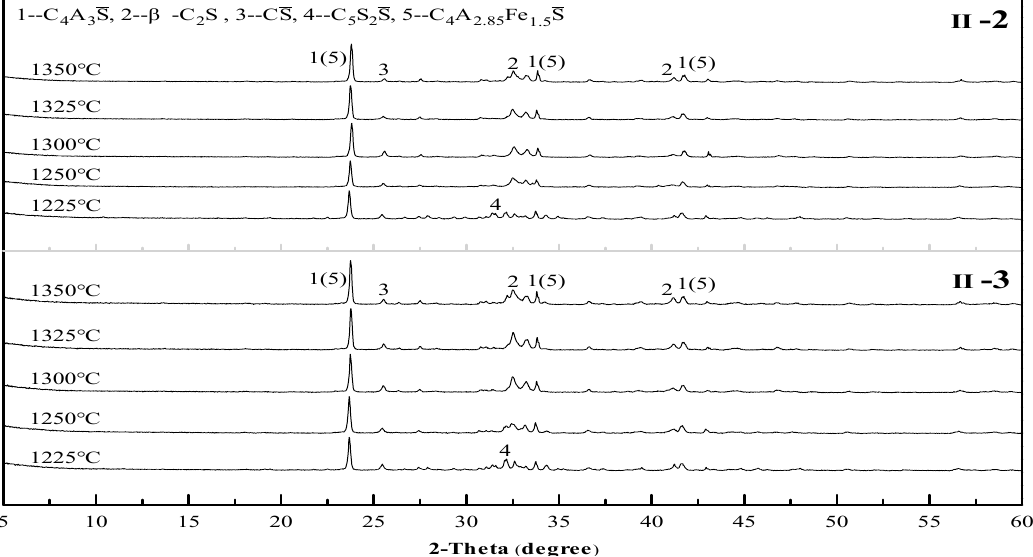
Figure 6. X-ray diffraction (XRD) patterns of the Series II cement clinkers at different temperatures.